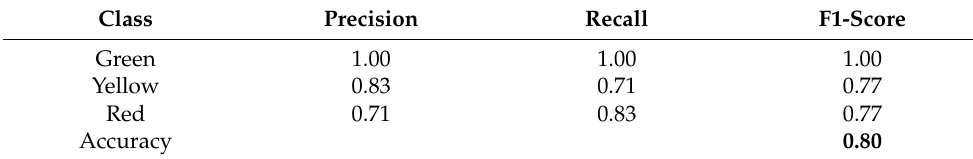
Table 11. Classification report for the SVC classifier.